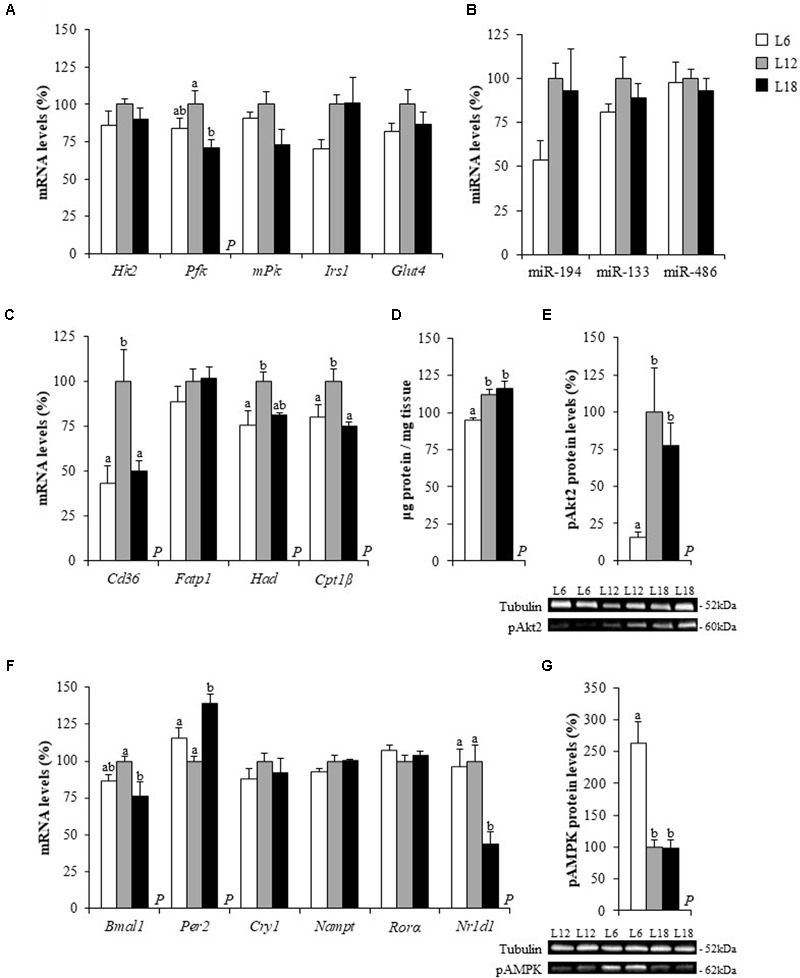
The mRNA levels of glucose metabolism (A), lipid metabolism (C) and circadian rhythm-related genes (F), microRNA expression levels (B), the total protein levels (D) and the protein levels of pAkt2 (E) and pAMPK (G) in the soleus muscle of male Fischer 344 rats fed with standard diet and exposed to three different photoperiods for 14 weeks. Data are represented as the mean ± SEM (n = 6). P, photoperiod effect (p < 0.05, one-way ANOVA). abMean values with different letters are significantly different among groups (p < 0.05, Duncan post hoc test). Cpt1β, carnitine palmitoyltransferase 1 beta; Fatp1, fatty acid transport protein 1; Glut4, glucose transporter 4; Hk2, hexokinase 2; Had, hydroxyacyl-CoA dehydrogenase; Irs1, insulin receptor substrate 1; mPK, pyruvate kinase type M; Pfk, phosphofructokinase; Tfrc, transferrin receptor. The rest of the genes analyzed have already been described in Figure 2.